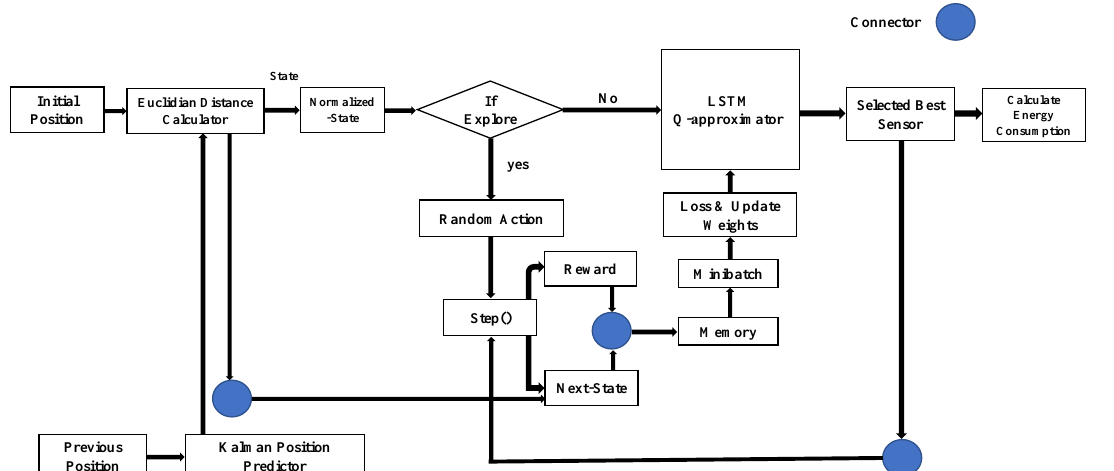
Figure 5. Proposed LSTM-DQN-epsilon-greedy system architecture. Algorithm 1: The proposed LSTM-DQN-epsilon-greedy